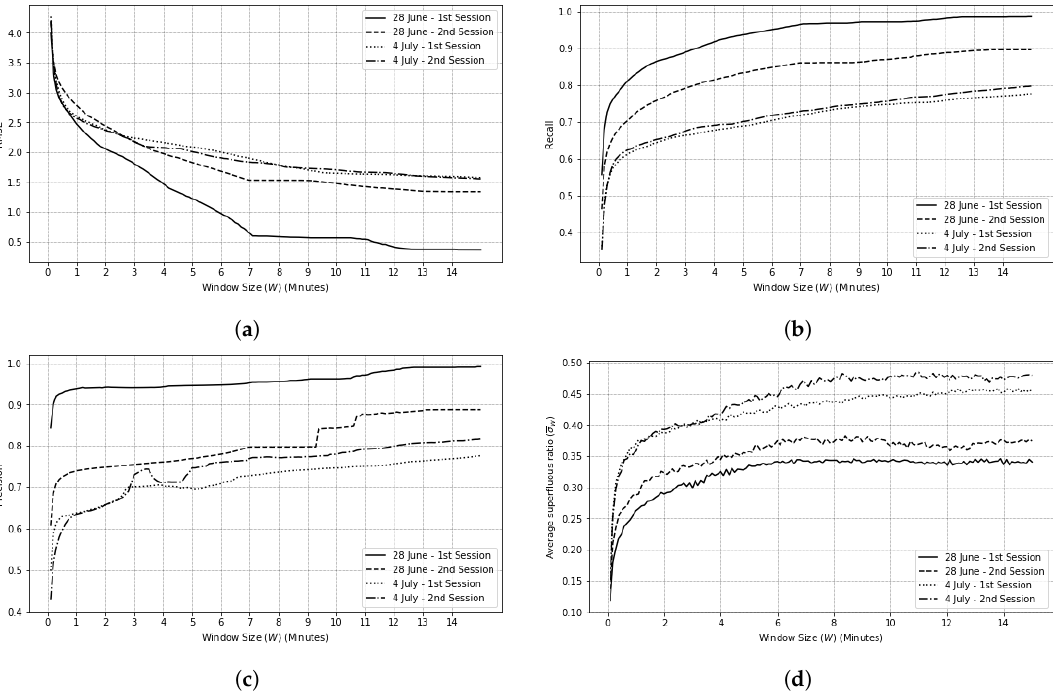
Figure 8. SAS analysis for motion sensors for different window sizes. ( a ) RMSE value, ( b ) recall value, ( c ) precision value, ( d ) superfluous ratio.